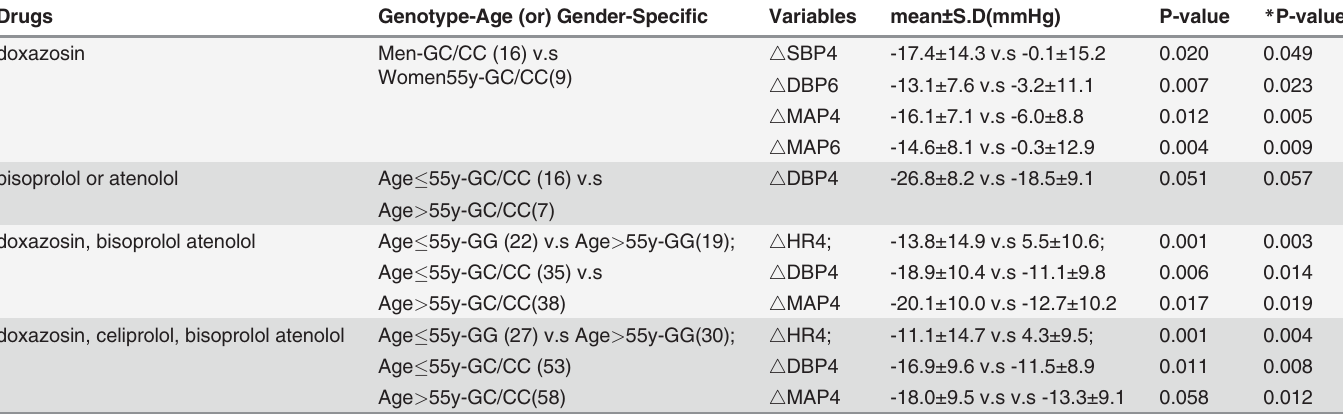
Table 3. Cardiovascular response to 4 weeks of α , β -ADR blocker therapy in EH patients, as stratified by the RGS2 genotype.